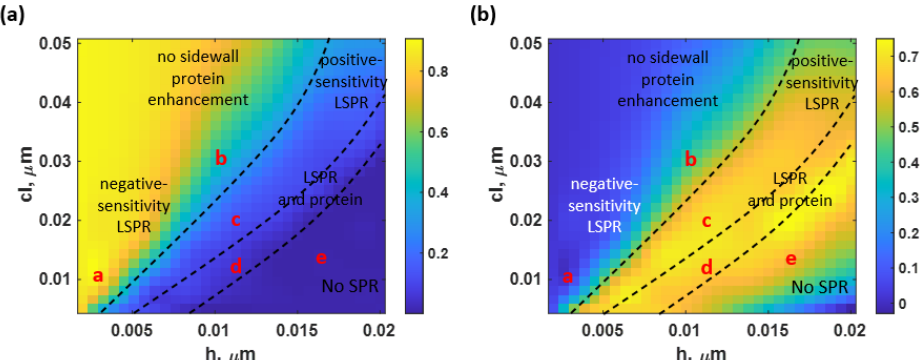
Figure 11. ( a ) the average Δ I and ( b ) the average I sp of both the nonsidewall BSA and the sidewall BSA models.